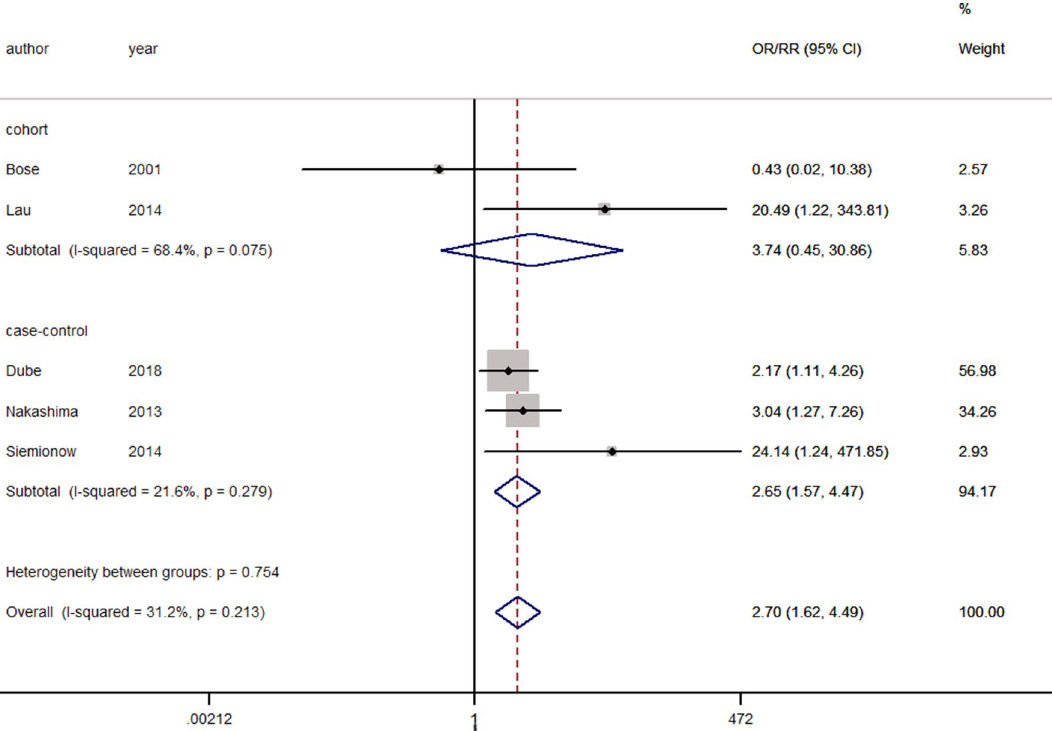
Figure 3. Forest plot showing the effect of smoking on respiratory complications. OR, odd rate; RR, risk rate; CI, confidence interval.